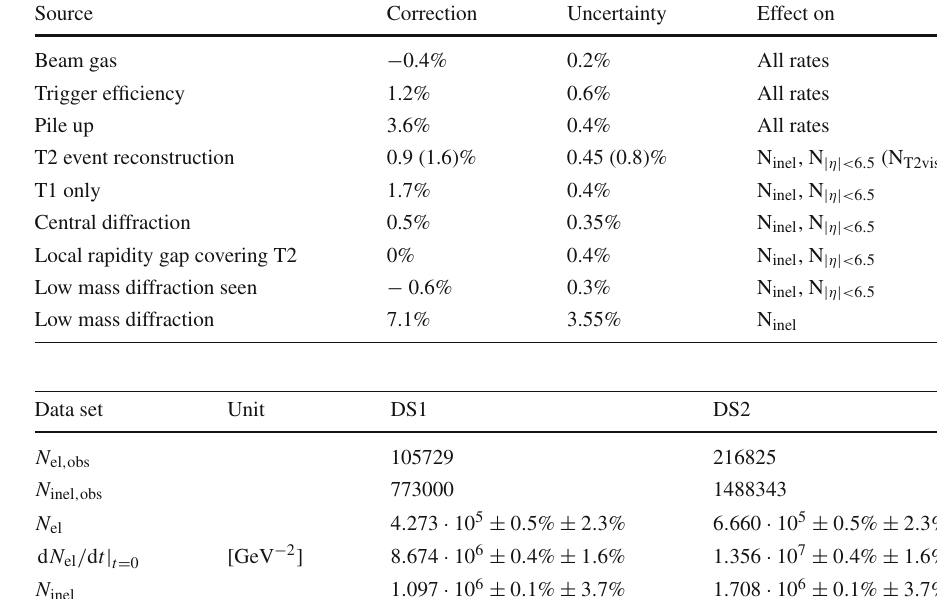
systematic uncertainties of the inelastic rate measurement. The second column shows the size of the correction, the third column the systematic uncertainty related to the source